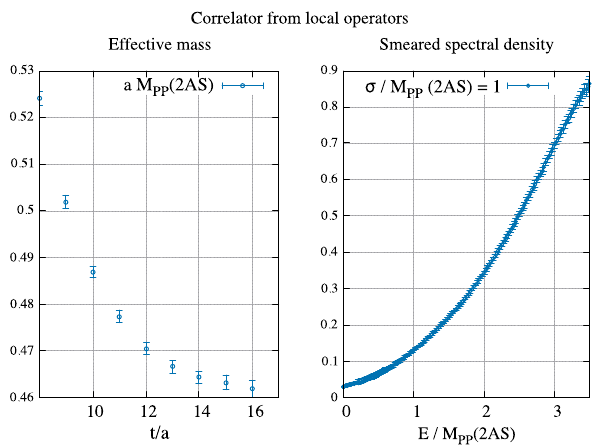
Fig. 8 Results from a two point function of pseudoscalar operators built with point-like antisymmetric fermionic fields. The correlator is estimated from the ensemble B1. The left panel exhibits the effective mass as a function of time. Due to the nature of the excited states in the 2AS sector, the mass does not reach a plateau in the available time. The dominance of the excited states can also be understood from the smeared spectral density in the right panel. The overlap between the interpolator and the excited states it creates is too large: the spectral density smeared according to Eq. (48) is dominated by contributions above the multi-particle threshold, preventing the identification of the ground state